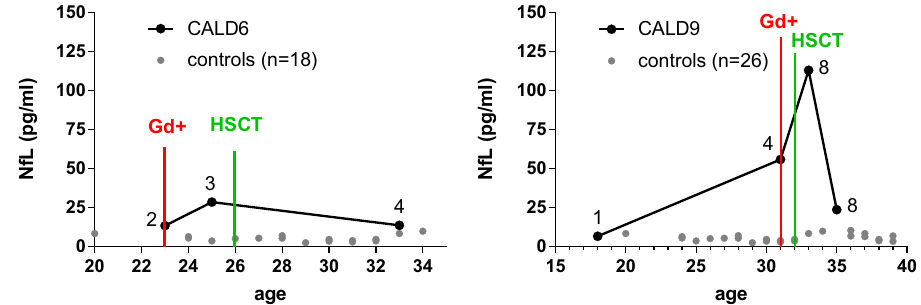
Fig. 5 NfL levels in CALD patients before and after HSCT. Longitudinal assessment of NfL in two adult CALD patients (CALD6 and CALD9) with classical CALD disease course before and after receiving HSCT. Numbers above each patient ’ s data points indicate the corresponding Loes scores of brain lesions on MRI. For comparison, gray circles show NfL levels of the healthy control cohort in similar age ranges (age 20 – 34, n = 18; age 20 – 39, n = 26). The time point at which Gd-enhancement (Gd + ) was initially detected is indicated by a vertical red line, the time point of HSCT intervention is marked by a green vertical line. Source data are provided as a Source Data fi